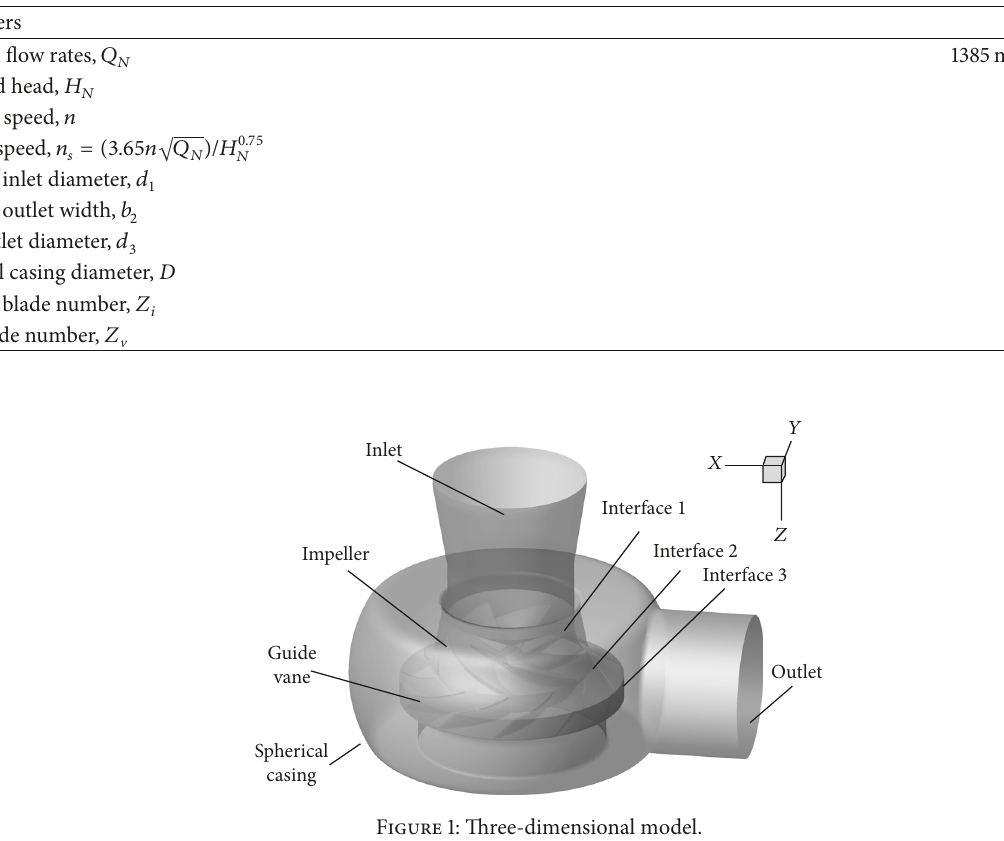
Table 1: Parameters of model pump.